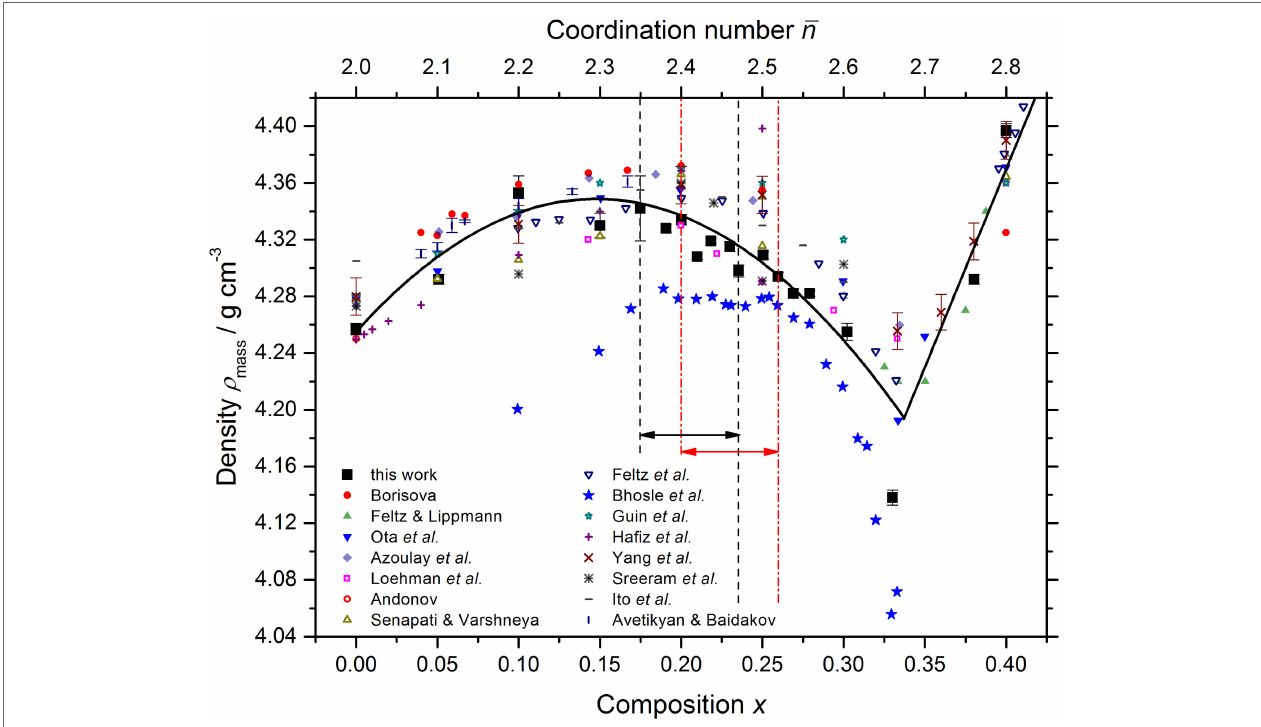
FIGURE 2 | The dependence of the mass density at room temperature (cid:26) mass for the Ge x Se 1 (cid:0) x system on the composition x and mean coordination number ¯ n = 2 ( 1 + x ) . The results from the present work at ≃ 22°C are compared to those taken from Andonov (1982), Avetikyan and Baidakov (1972), Azoulay et al. (1975), Bhosle et al. (2012b), Borisova (1981), Feltz et al. (1983), Feltz and Lippmann (1973), Guin et al. (2002b), Hafiz et al. (1993), Ito et al. (1988), Loehman et al. (1972), Ota et al. (1978), Senapati and Varshneya (1995), Sreeram et al. (1991b), and Yang et al. (2013). The solid (black) curves are drawn as guides for the eye. The pairs of vertical dashed (black) or chained (red) lines, and associated horizonal arrows, mark compositions for which ∆ H nr ≃ 0 as found in the present work or in the work of Boolchand et al. (2001a), respectively.